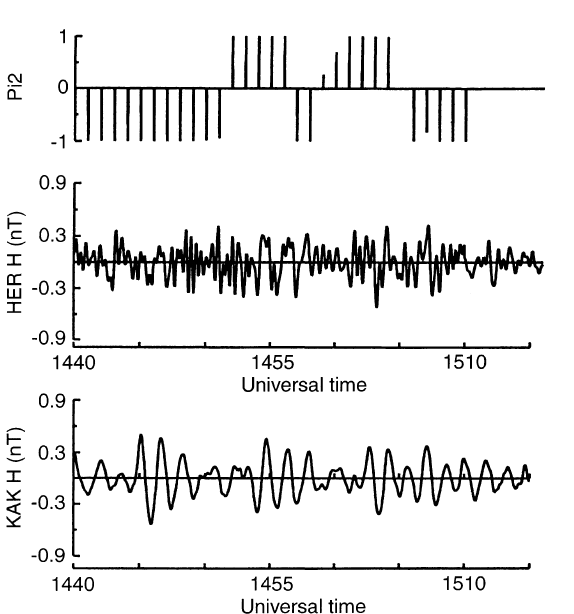
Fig. 6. Example where the ANN was able to identify Pi2 signatures which were not visually discernible due to the presence of Pc3 pulsations. The upper diagram shows the sequence of ANN output values obtained for the input data in the centre diagram. The Kakioka magnetometer data ( lower ) confirms the occurrence of Pi2 signatures Fig. 7. Examples where the ANN failed to identify Pi2 signatures